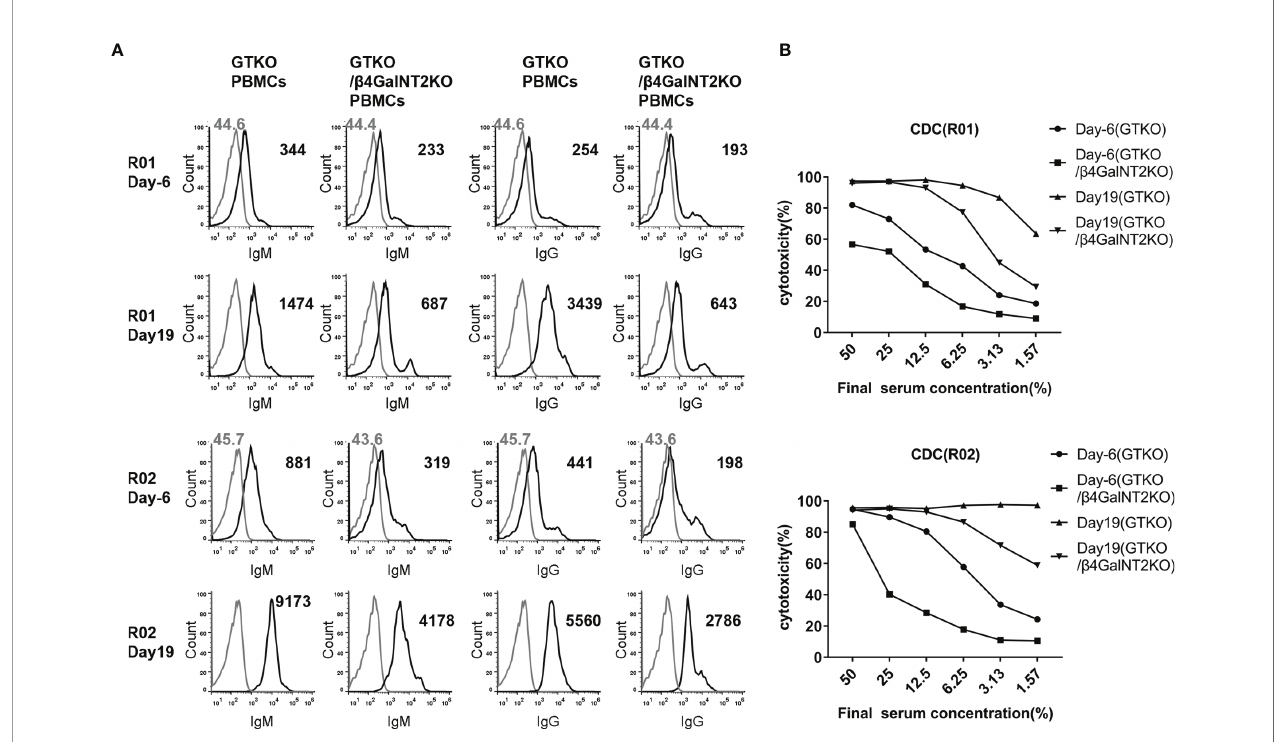
FIGURE 6 | The role of induced antibodies against Sda in the development of acute humoral xenograft rejection in GTKO/hCD55 pig-to-rhesus monkey kidney xenotransplantation. Renal xenotransplantation was previously performed in four rhesus monkeys using kidneys from GTKO/hCD55 pigs. Two of the four recipient monkeys (R01 and R02) generated high levels of circulating antibodies against non-Gal antigens and developed acute humoral xenograft rejection on day 19. Serum samples collected before transplantation (day -6) and at the time of rejection (day 19) were used to measure IgM/IgG antibody binding and CDC against GTKO (Sda mo ) or GTKO/ b 4GalNT2KO pig PBMCs. (A) The FACS results of serum IgM and IgG binding to pig PBMCs (at a serum concentration of 10%). Cells were incubated with medium served as negative controls (gray lines). The number represents the geometric mean fl uorescence intensity (Gmean). (B) Comparison of CDC (at serum concentrations of 50% to 1.57%) of rhesus monkey (R01 and R02) pre-transplant (day -6) and post-transplant (day 19) serum against GTKO and GTKO/ b 4GalNT2KO pig